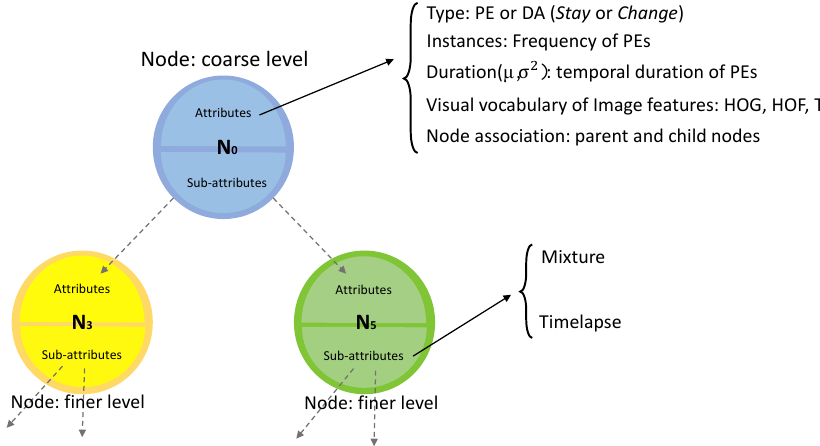
Figure 5. An example of model architecture in node level where each node is composed of attributes and sub-attributes. DA = discovered activity; HOG = istogram of Oriented Gradients; HOF = Histogram of Optical Flow; TDD = Trajectory-Pooled Deep-Convolutional